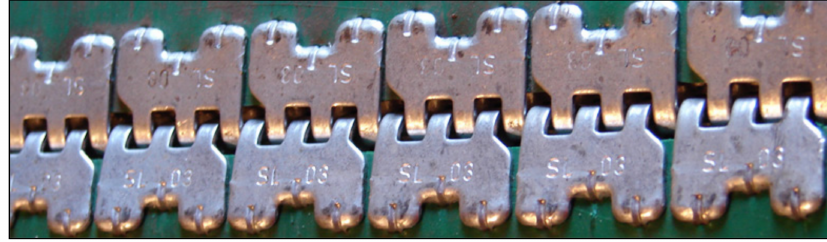
Figure 20. Metal clamps fastening: general view [26].